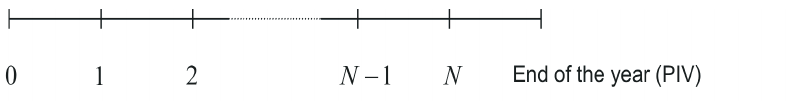
Figure 1. General inspection